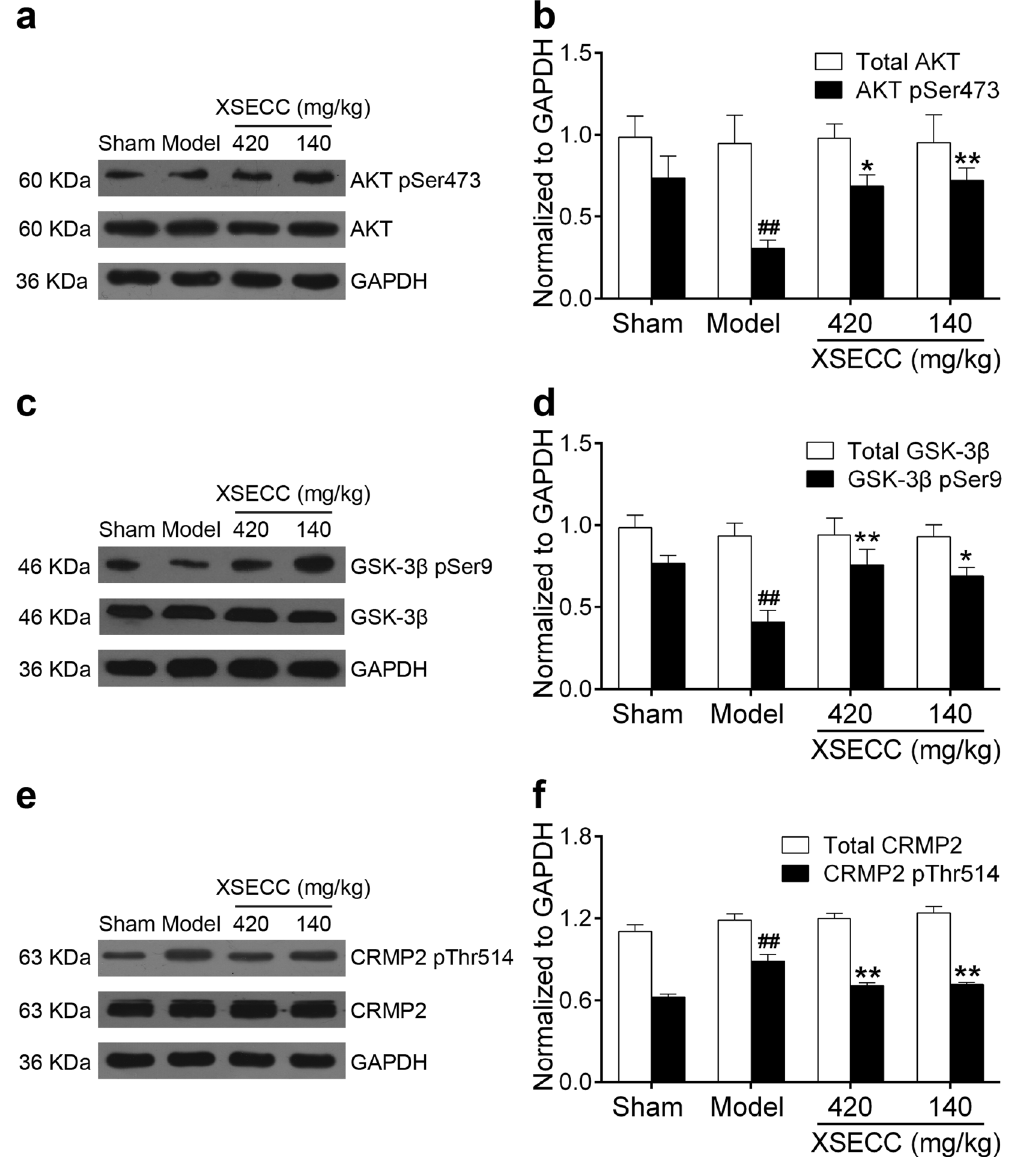
Figure 7. Effects of XSECC on the protein expressions of AKT/GSK-3 β /CRMP2 signaling pathway after BCCAO. Protein and phosphorylation protein level of AKT ( a , b ), GSK-3 β ( c , d ) and CRMP2 ( e , f ). ## P < 0.01 vs . sham group; * P < 0.05, ** P < 0.01 vs . model group (one-way ANOVA followed by LSD’s post hoc test, n = 6 per